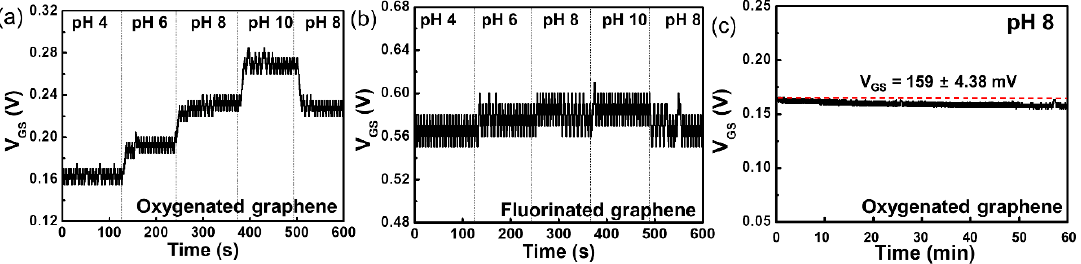
Figure 3. Characteristic graphs of fluorinated G-ISFET: ( a ) I DS – V DS transfer characteristic with respect to V GS and ( b ) I DS – V GS transfer characteristic with respect to pH value.